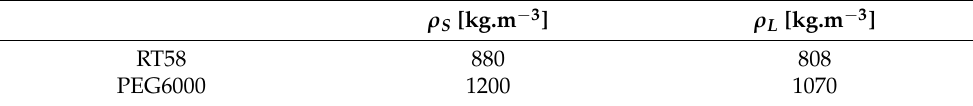
Table 1. Values of solid and liquid densities identified